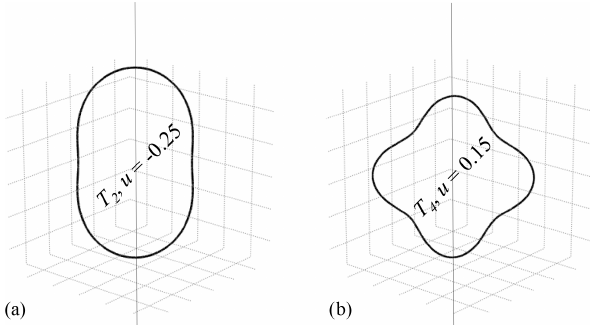
Figure 3. Examples of the Chebyshev particles used. (a) Chebyshev particle of the second degree ( T 2 ) with deformation parameter u = − 0 . 25 and (b) Chebyshev particle of the fourth degree ( T deformation parameter u = 0 .